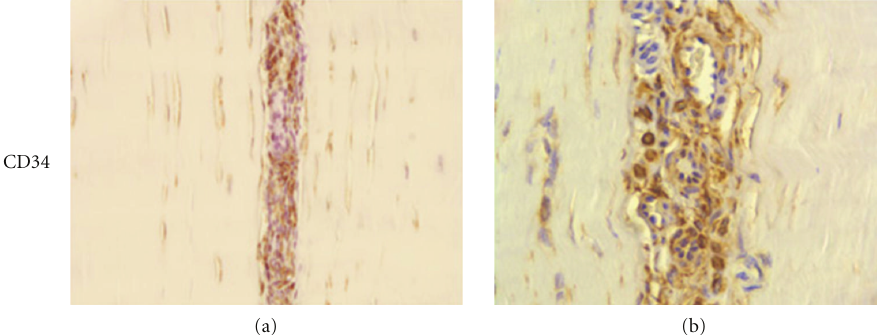
Figure 3: Tissue slides obtained from SDFTs injected with cBMSCs, and BMMNCS. Tissue stains with hematoxylin-eosin (H and E) and Herovyci (Hero) highlight the longitudinal orientation of collagen fibers after transplantation of cBMSCs and BMMNCS; Histological examination of the sham tendons, both with HE and Herovyci staining, showed the presence of mature collagen (i.e., predominantly strong red Herovyci staining of fibers in tendon sections) and a longitudinal fiber orientation, signifying a normal tendon architecture. Additionally, the absence or very scanty mononuclear cell infiltrate was observed in all normal control tendons. No inflammatory or other reactions to the fibrin glue were observed in any of the treated limbs, and at T21 no fibrin residues were recognized in microscopic examinations. (T21) Tissue slides from the superficial digital flexor tendons (SDFT) following experimentally induced tissue injury and subsequent treatment with cultured bone marrow mesenchymal stem cells (cBMSCs (a)) and Bone Marrow Mononucleated Cells (BMMNCS (b)). Incomplete maturation of collagen was verified by the observation of blue staining fibers mixed with red ones. In BMMNCS a large number of mononucleated cells are recognizable in the interfascicular zone. Immunohistochemistry stains for Collagen type I (C/I) and collagen type III (C/III) show a high expression of C/I and a very low expression of C/III. Stains for cartilage oligomeric matrix protein (COMP) expression. BMMNCS-treated SDFT (b) show a strong, di ff use expression like sham SDFT (Figure 4(c)). Immunohistochemistry staining for the expression of CD34+ mononucleated cells in cBMSCs (a) shows a low expression limited to the interfascicular zone. In BMMNCS (b)-treated SDFT, the presence of numerous mononucleated CD34+ cells near microvessels, which sometimes show some CD34+ endotheliocytes in their wall, which is highlighted. In cBMSC- and BMMNCS-treated SDFTs, microscopic examination at T21 revealed a longitudinal orientation of newly formed collagen fibers. At this time point, sections stained by the Herovyci method revealed minimal areas of blue-stained thin, well-oriented precollagen fibers mixed with well-di ff erentiated and- oriented red-stained mature collagen fibers, indicating a still somewhat incomplete collagen maturation at this time in the treatment. In BMMNCS-treated SDFTs also, large numbers of mononucleated cells were present in the interfascicular zone. In contrast, in placebo SDFTs, injected with saline or fibrin, the tissue architecture was disrupted or markedly modified, showing blue precollagen and red collagen fibers randomly or not longitudinally oriented, and a relatively loss of the architectural